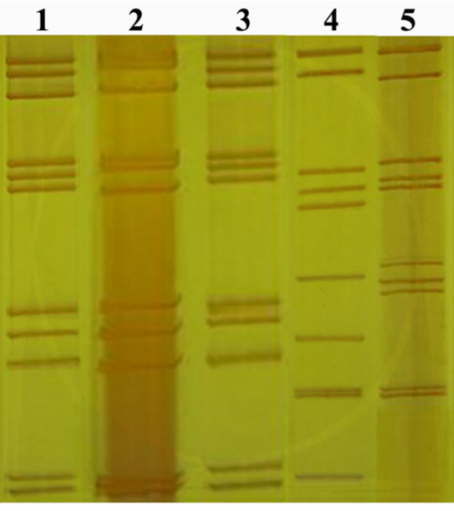
Figure 4. SDS-PAGE electropherotyping of GCRV and GSRV dsRNA genomic segments Lane 1 GCRV-GZ1208, Lane 2 GCRV-873, Lane 3 GSRV, Lane 4 GCRV-HZ08, and Lane 5